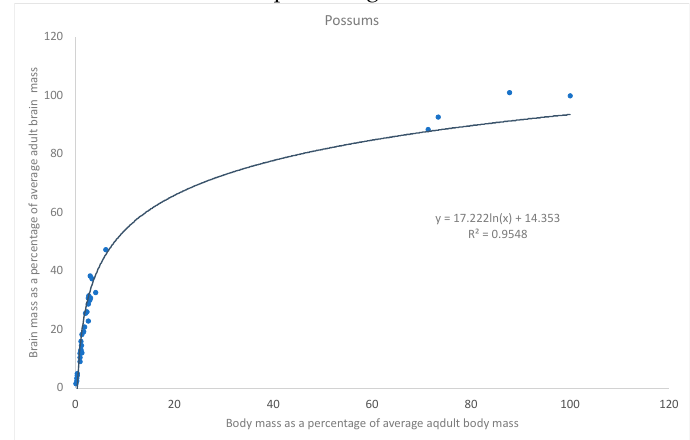
Body mass as a percentage of average aqdult body mass